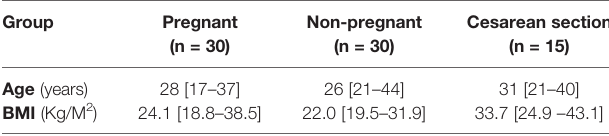
TABLE 1 | Baseline characteristics of participants.